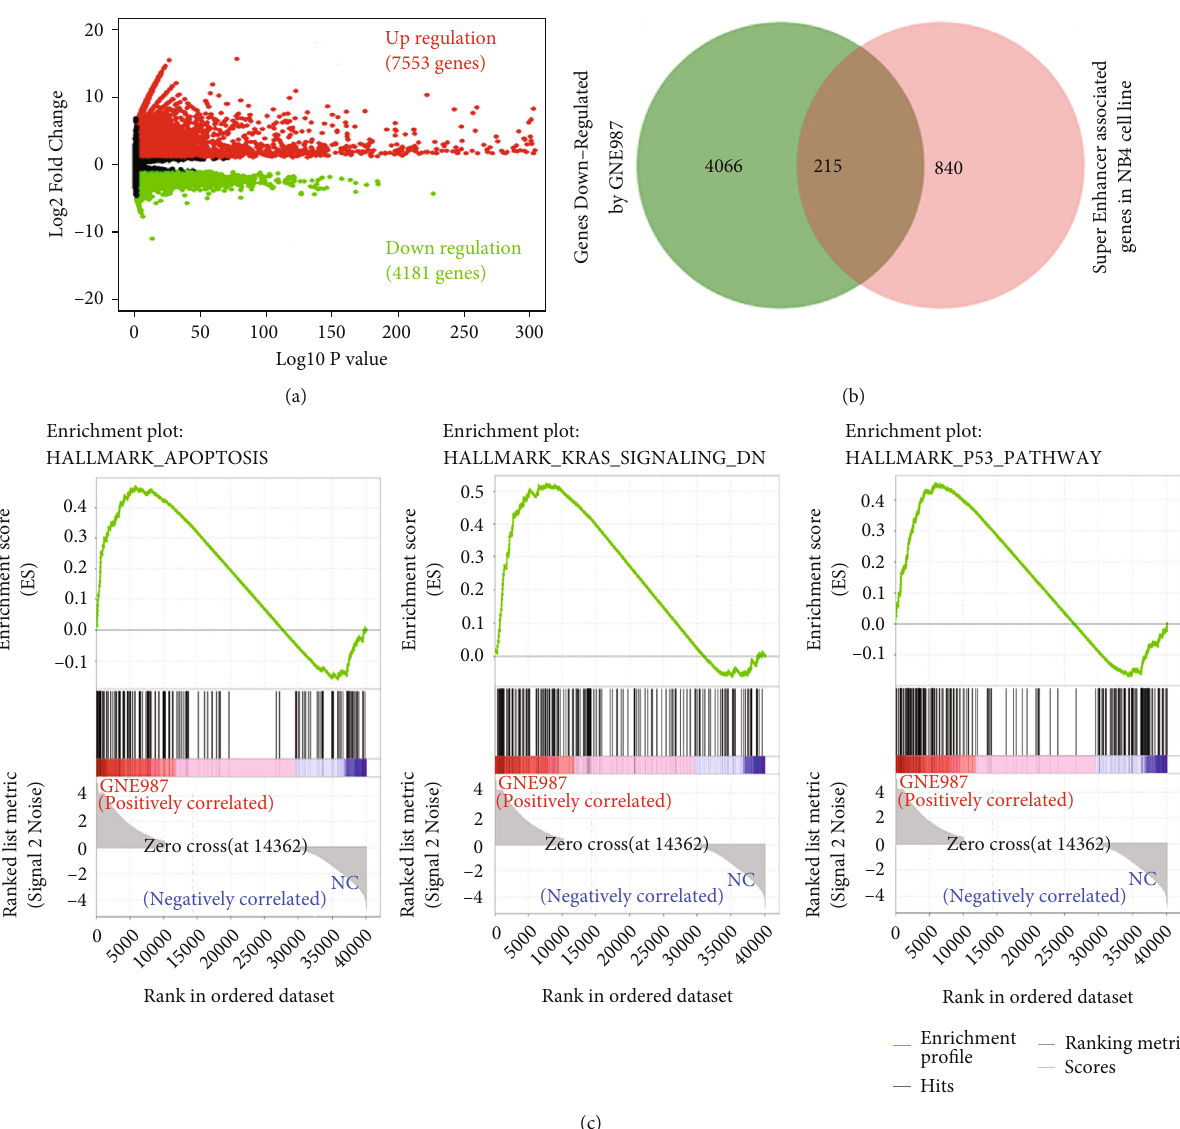
Figure 8: In AML cells, after GNE987 treatment, the expression of many super-enhancer-related genes is downregulated. (a) Compared with the control group, in GNE987-treated NB4 cells, the expression of a total of 11834 genes was a ff ected (upregulation of 7553 genes and downregulation of 4281 genes). (b) Venn diagram of genes related to superenhancers and sensitive to GNE987 in NB4 cells. (c) The GSEA diagrams show that the di ff erently expressed genes in GNE987-treated NB4 cells were enriched in the apoptosis, KRAS, and P53 signaling